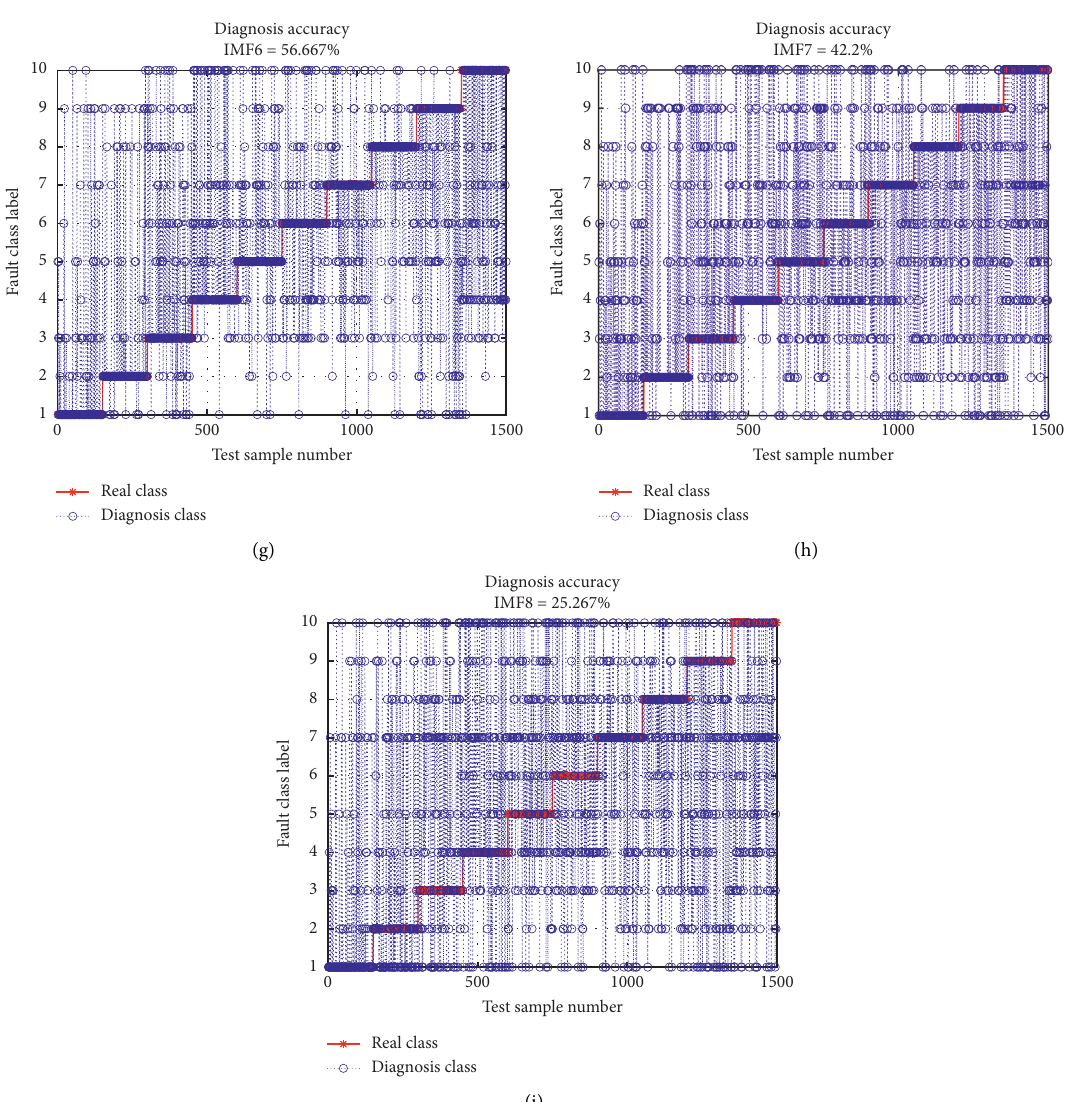
Figure 5: Diagnosis accuracy produced by individual DMLYu with original signal and IMF component. Diagnosis accuracy produced by individual DMLYu (a) with original signal, (b) with IMF1 component, (c) with with IMF2 component, (d) with IMF3 component, (e) with IMF4 component, (f) with IMF5 component, (g) with IMF6 component, (h) with IMF7 component, and (i) with IMF8